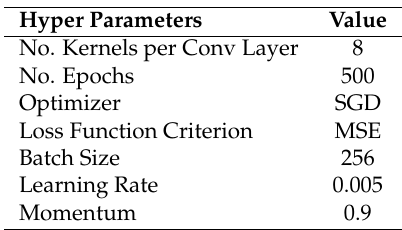
Table 1. Hyper parameters for training a full-precision